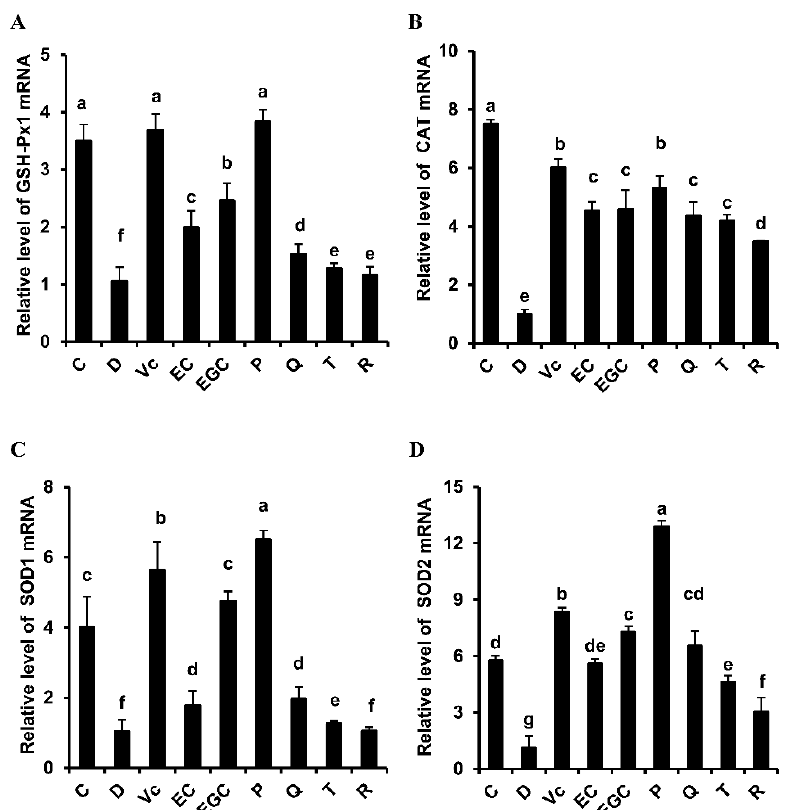
Figure 4. E ff ect of six flavonoids on hepatic oxidative stress in d -galactose-treated mice. ( A ) glutathione Figure 4. Effect of six flavonoids on hepatic oxidative stress in D ‐ galactose ‐ treated mice. ( A ) peroxidase 1 (GSH-Px1) mRNA expression level; ( B ) catalase (CAT) mRNA expression glutathione peroxidase 1 (GSH ‐ Px1) mRNA expression level; ( B ) catalase (CAT) mRNA expression